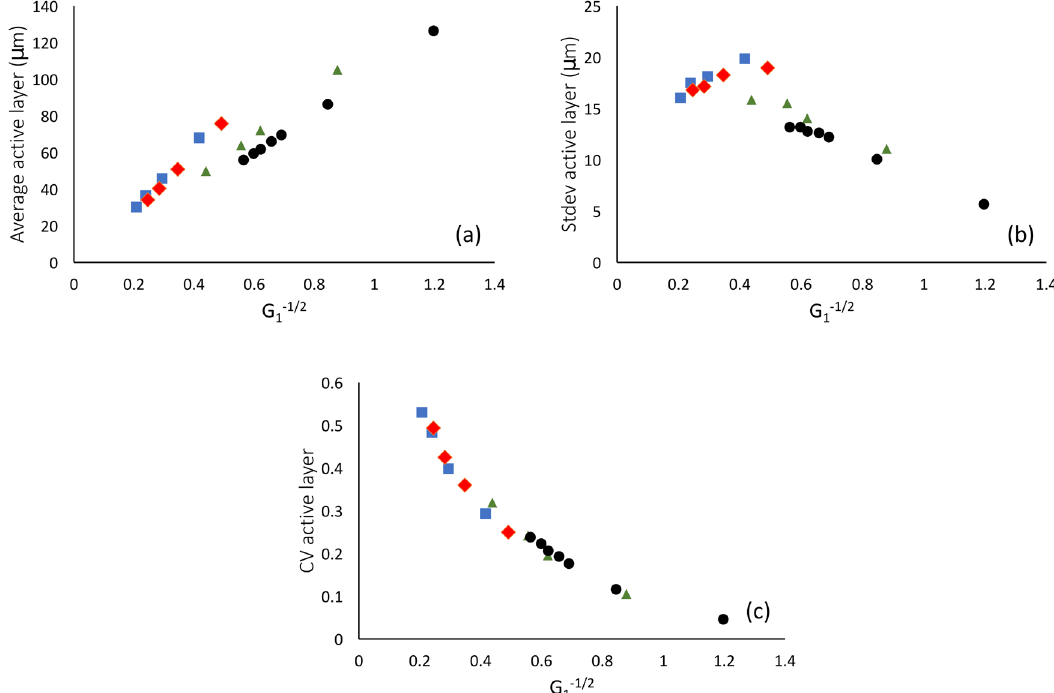
Fig. 3 Dimensionless control parameter and the active layer. a Average active layer thickness (averaged across the bio fi lm width for steady- state simulations, see Methods), b Standard deviation of the active layer thickness, and c Coef fi cient of variation of the active layer thickness, i.e. standard deviation divided by the mean. In all panels, the parameter on the horizontal axis is the dimensionless combined parameter proposed by ref. 11 , G (cid:2) 1 2 ¼ð D B Y ð k S þ S bulk Þ = ð L 2 ρμ max ÞÞ 1 2 . The data points correspond to 19 simulations with different values of the parameters S bulk and y 1 μ = 0.0005 g/L, μ = (0.1, 0.2, 0.3, 0.4)/h; Red diamonds: max . Data points are grouped according to their S bulk values. Blue squares: S bulk max S bulk = 0.001 g/L, μ max = (0.1, 0.2, 0.3, 0.4)/h; green triangles: S bulk = 0.005 g/L, μ max = (0.1, 0.2, 0.25, 0.4)/h; black circles: S bulk = 0.01 g/L, = (0.1, 0.2, 0.3, 0.33, 0.37, 0.4, 0.45)/h. See Supplementary Fig. 6 for an equivalent analysis with the alternative combined parameter G (cid:2) 1 2 μ max 2